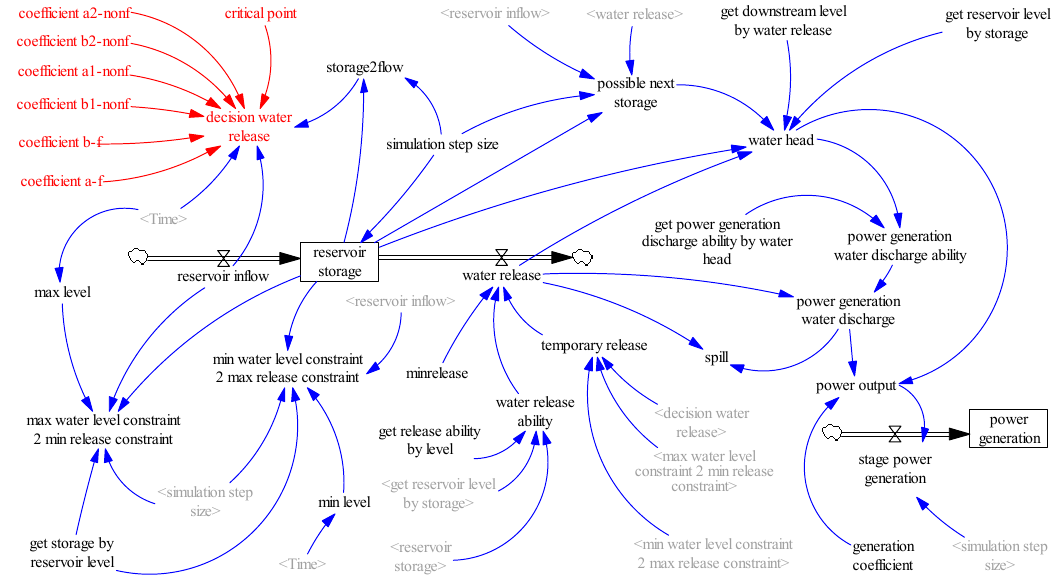
Figure 10. A practical system dynamics (SD) simulation model coupled with operating rules.